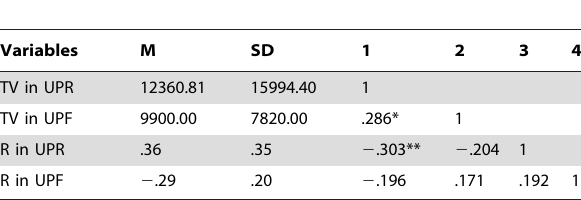
Table 1. Descriptive Statistics and Correlation Analysis of Returns and Trading Volume.